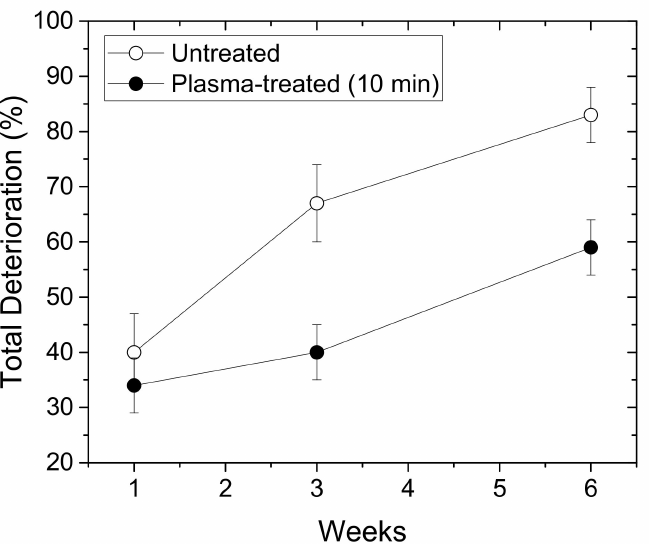
Figure 3. Total deterioration (%) of chrysanthemum synseeds grown ex vitro during 6-week period. Empty symbols: untreated synseeds; full symbols: plasma-treated synseeds.